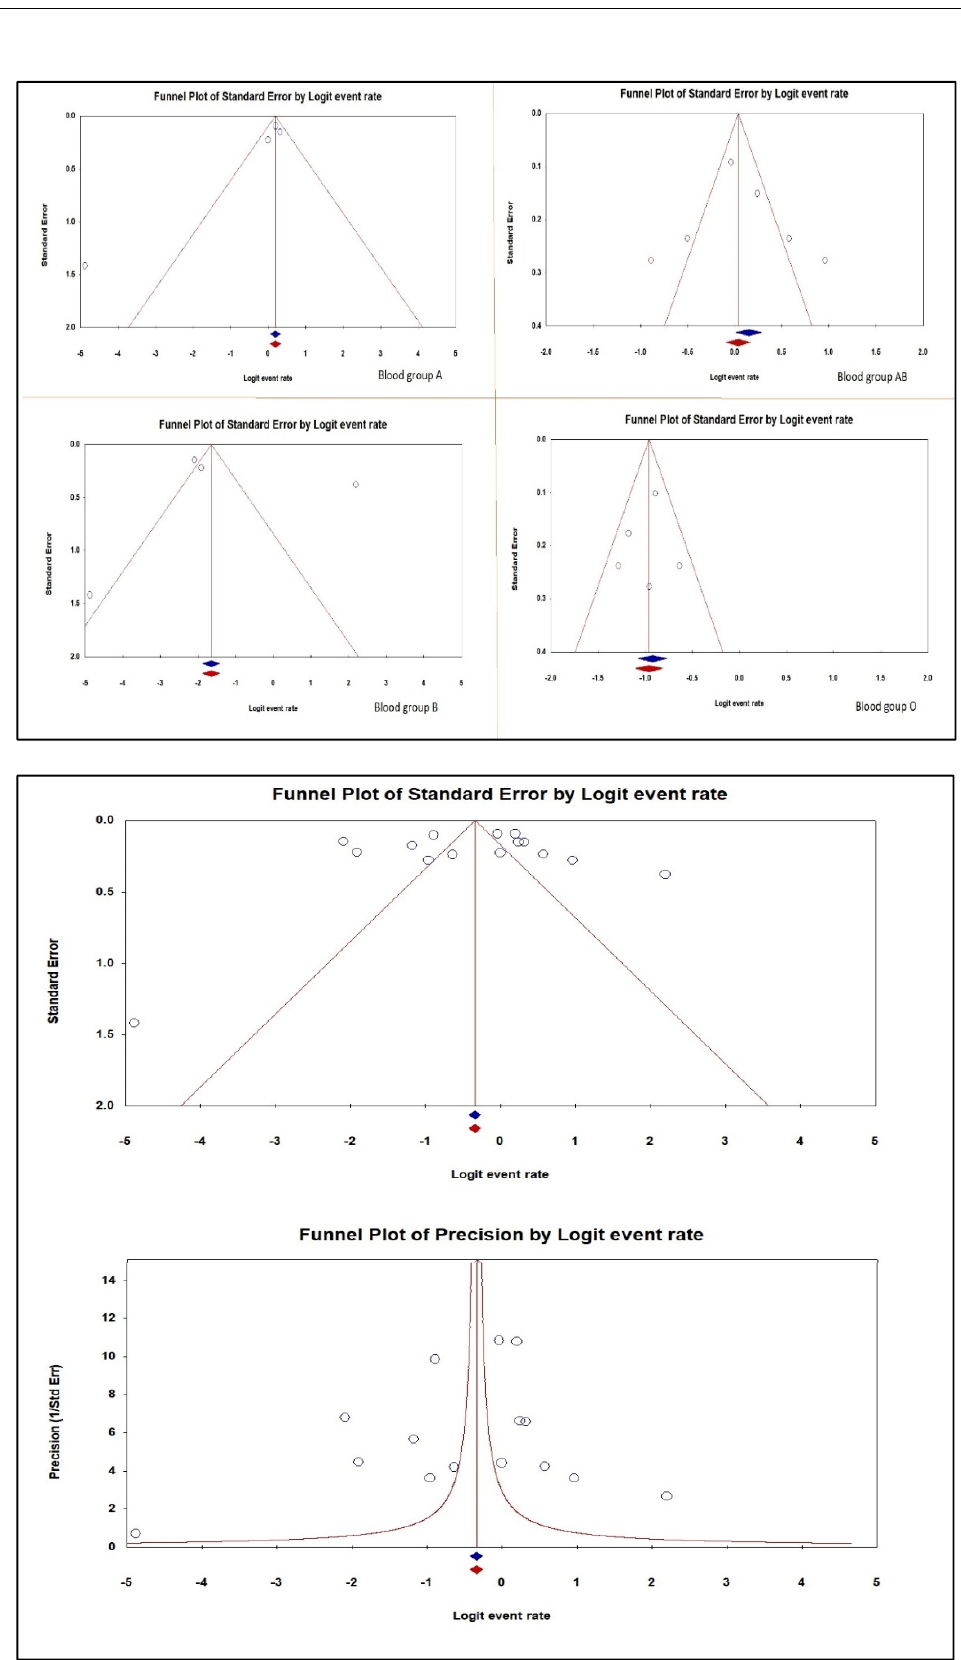
Figure 3. Publication bias of the ABO Blood group susceptibility to venous thromboembolism in individuals with Factor V Leiden